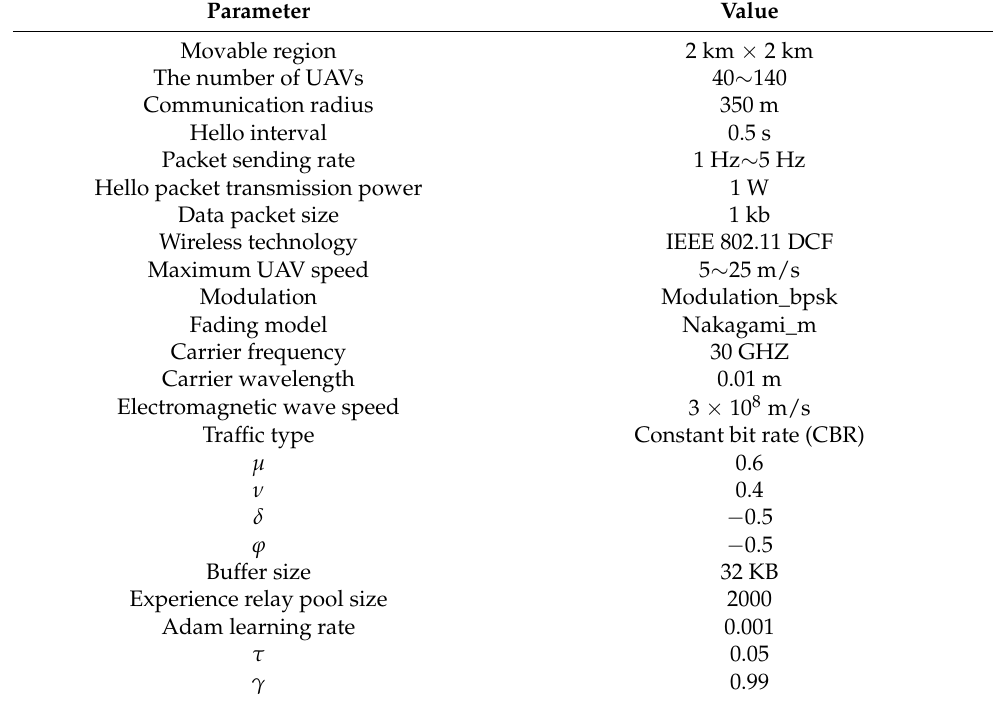
Table 1. Simulation